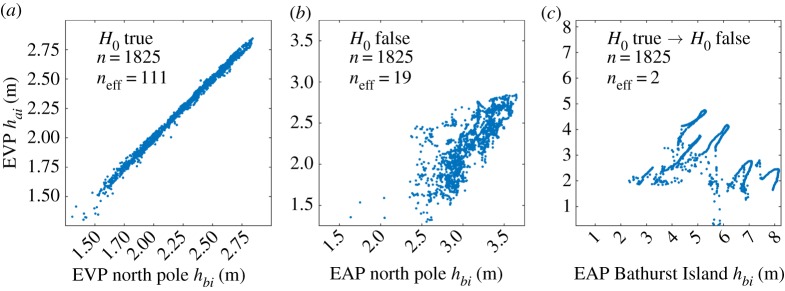
Demonstration of the Two-Stage Paired Thickness Test (2SPT) for daily concentration-weighted ice thickness series from the Regional Arctic System Model (RASM) extending for 5 years from 1996 to 2000 (n = 1825): (a) The Stage-1 t-test in equation (3.3) confirms the null hypothesis, , for hai and hbi taken from adjacent grid cells at the North Pole for the EVP simulation. (b) The t-test in equation (3.3) confirms the alternate hypothesis, , for respective hai and hbi series co-located at the North Pole for EVP and EAP simulations, so that the test stops at Stage-1 even though neff < 30. (c) The test proceeds to Stage 2 because neff < 30 for co-located perennial ice time series north of Bathurst Island and the t-test in equation (3.3) confirms H0. The Stage-2 test using equation (3.1) with the look-up table in table 2 subsequently corrects the outcome to confirm the alternate hypothesis, H1. Time series locations used in this figure are tagged in figure 4h in magenta. (Online version in colour.)